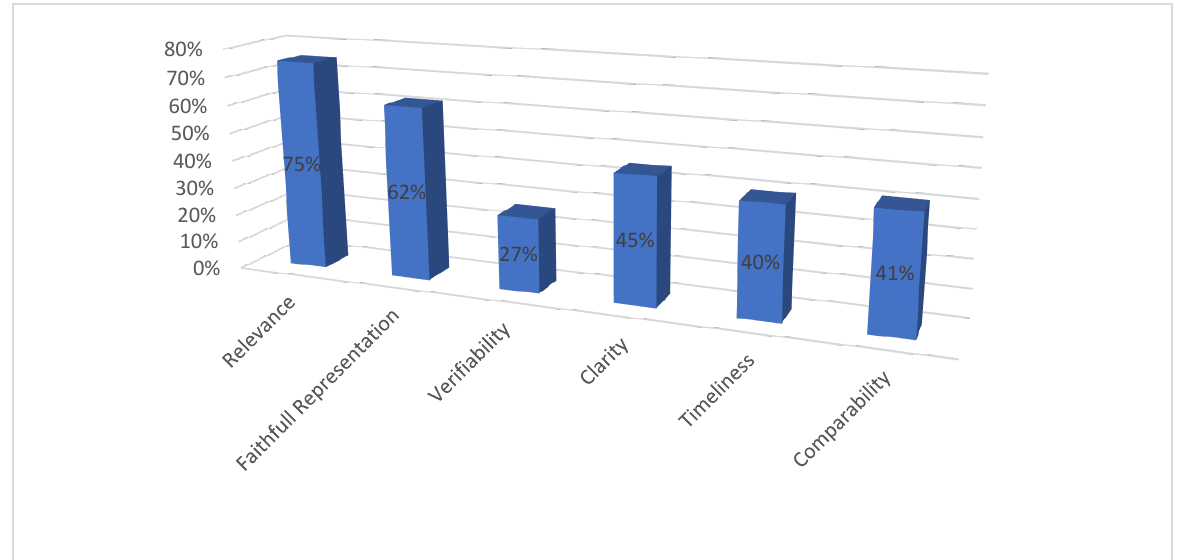
Figure 4. Overall assessment of decision usefulness of integrated reports produced in Namibia. Source: Authors own illustration.